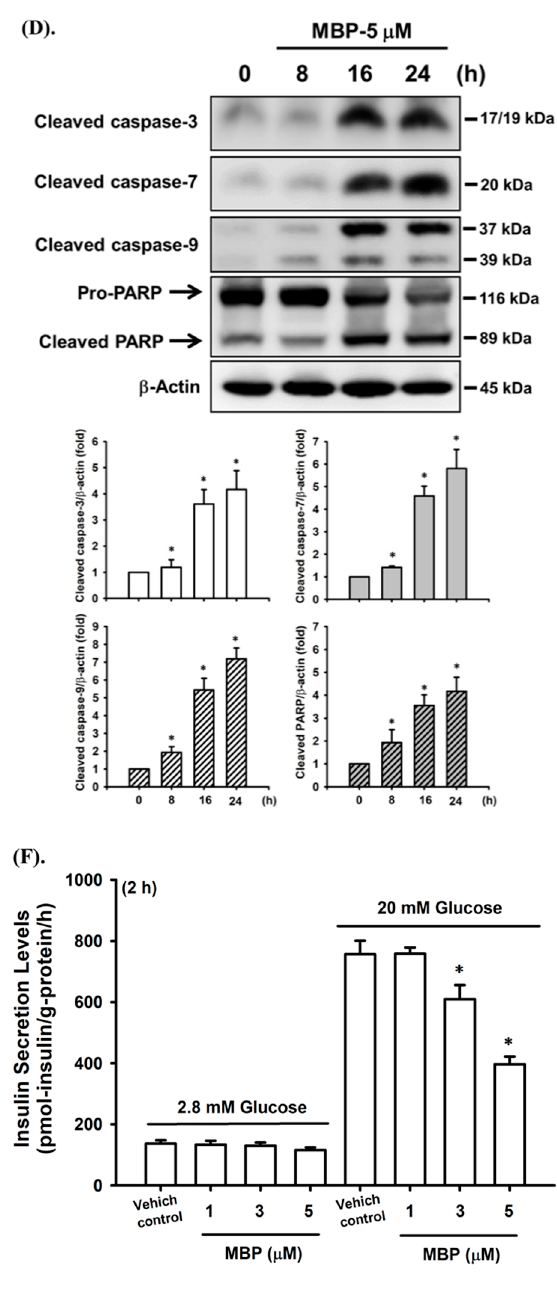
Figure 2. Effects of MBP on cytotoxicity, apoptosis, and insulin secretion in RIN-m5F cells. The cells were treated with MBP (0–15 μ M) for 24 h; subsequently. ( A ) Cell viability was detected using the MTT assay. ( B ) Cytotoxicity was deter- mined using the LDH release assay. ( C ) Caspase-3 activity was determined using the caspase-3 activity fluorometric assay kit. ( D ) The protein expression of cleaved caspase-3, -7, and -9 and cleaved PARP proteins was examined using Western blot analysis. The quantification was performed using densitometric analysis. ( E ) In addition, RIN-m5F cells were treated with 5 μ M MBP for different time intervals (2–24 h). Cell viability was determined using the MTT assay. ( F ) RIN-m5F cells were treated with MBP (1–5 μ M) for 4 h. The insulin secretion stimulated by 2.8 mM or 20 mM-glucose was detected using an immunoassay kit. Data are presented as the mean ± S.D. of four independent experiments assayed in triplicate. * p < 0.05 compared to the vehicle